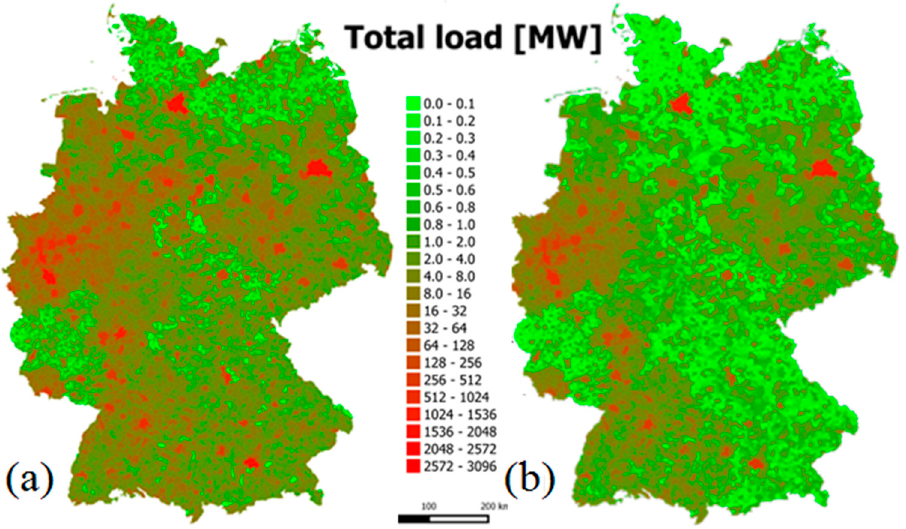
Figure 5. Electrical load with adjusted load factors in 2013 for Germany, according to the